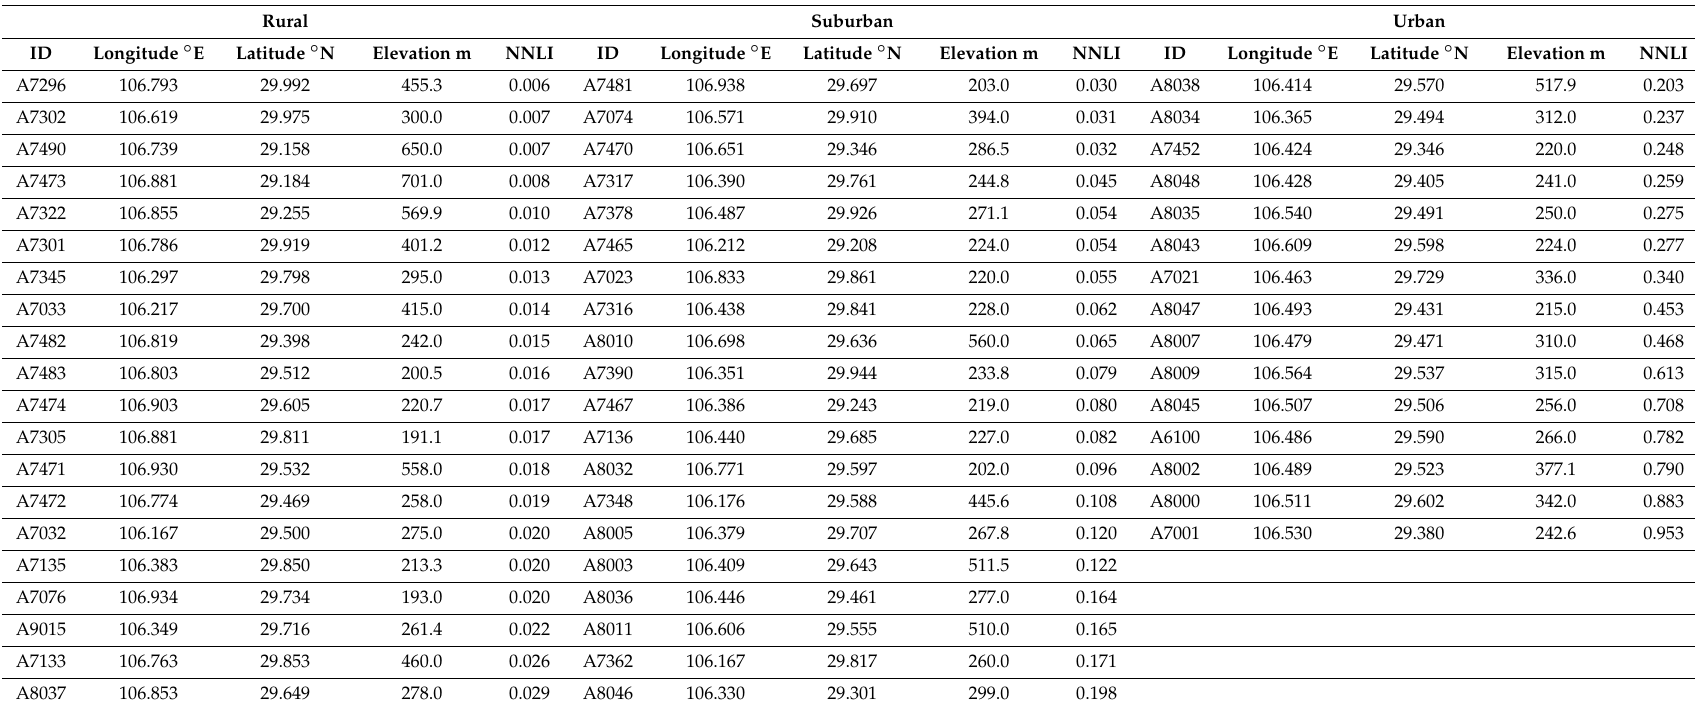
Table 1. Detailed information of automatic weather stations (AWSs) in the research